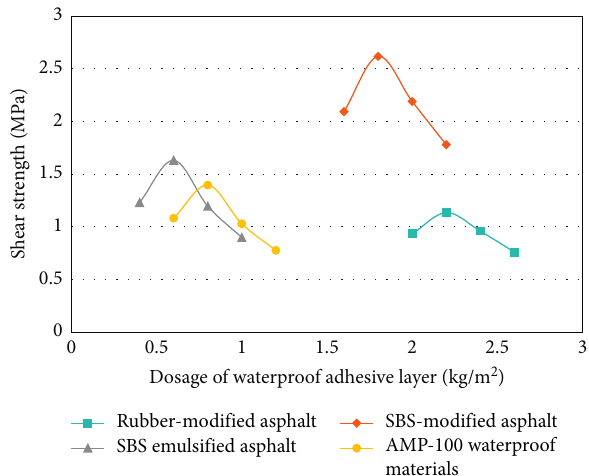
Figure 4: Shear strength of four types of waterproof adhesive layers with different dosages.